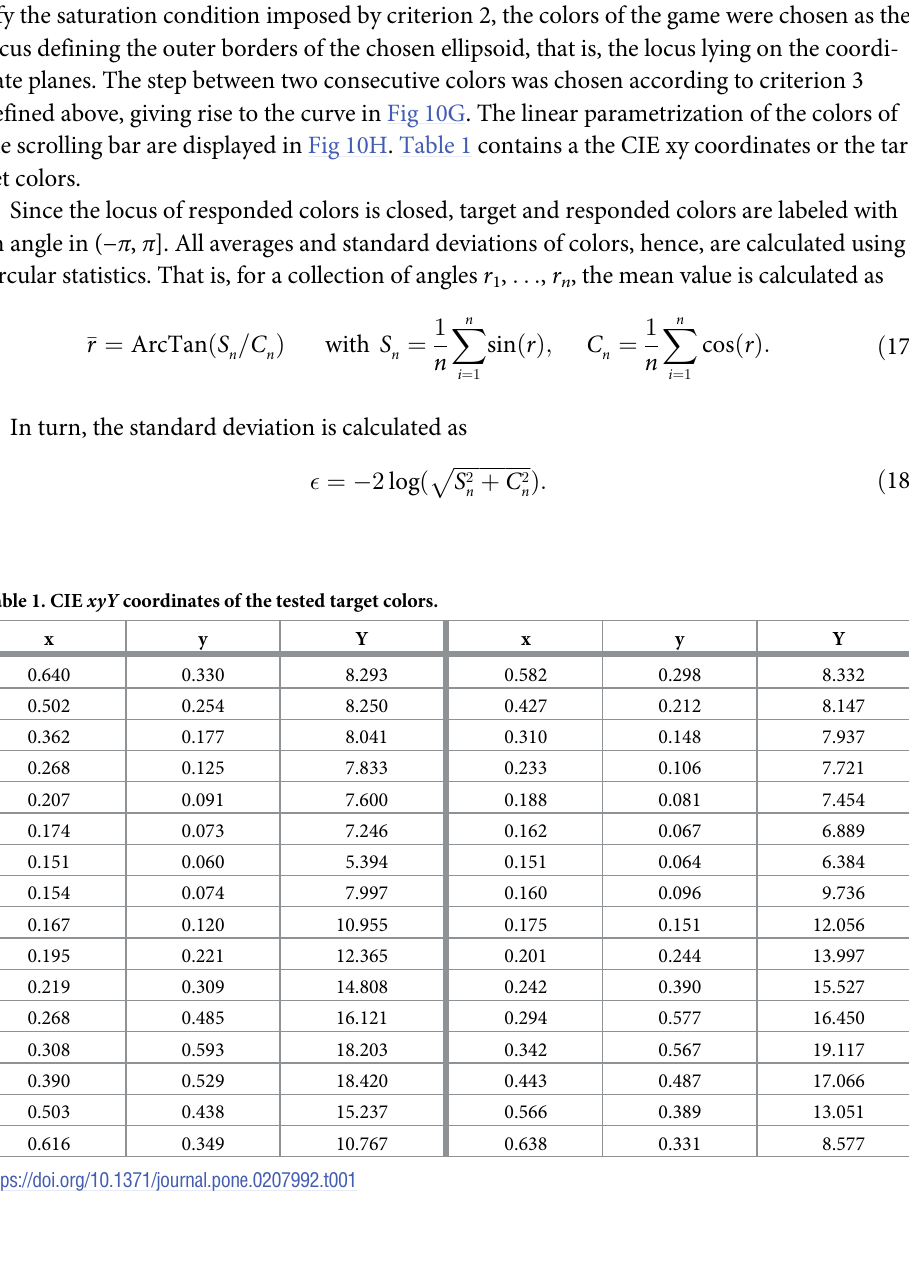
models. D: Square residuals of the two proposed models as a function of wavelength. Black: quadratic model. Gray: linear model. E: Total light intensity as a function of the coordinates R, G and B. Intensity is represented by the volume of each sphere. Each axis ranges between 0 an 255. F: Quadratic fit of a surface with constant intensity. Each axis ranges between 0 and 255. G: Locus of colors used in the game. Continuous colored curve: the 743 colors swept by the scrolling bar. Black points: the 32 target colors. H: Linear parametrization of the colors displayed in G.